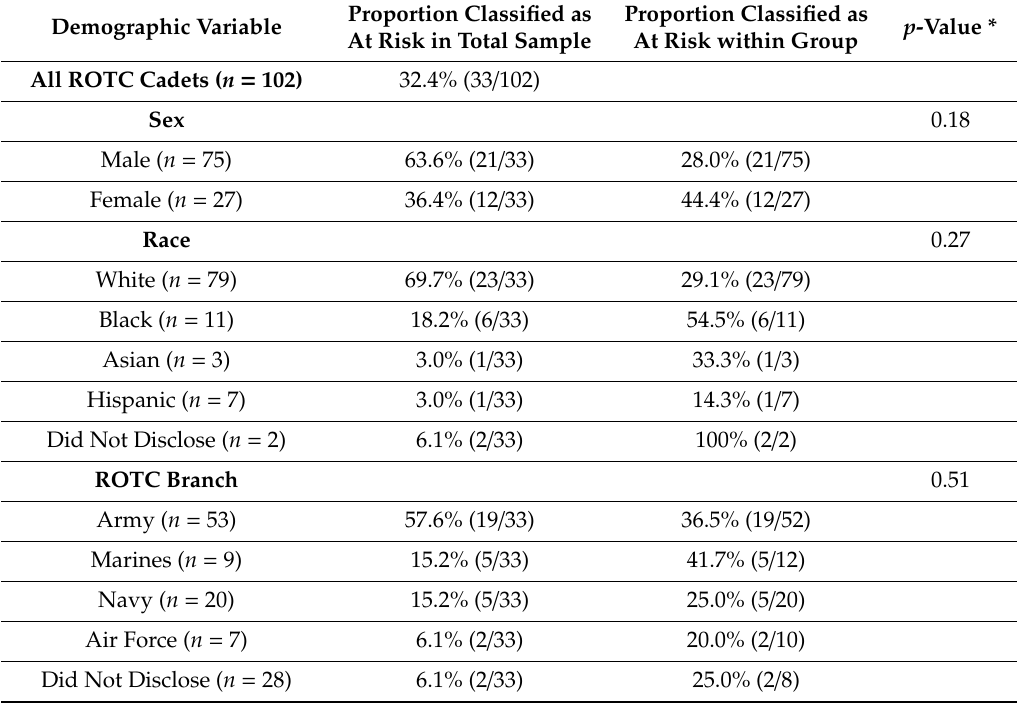
Table 2. Proportion of Reserve O ffi cer Training Corps (ROTC) cadets classified as at risk for eating disorders (reported in percent and sample size).